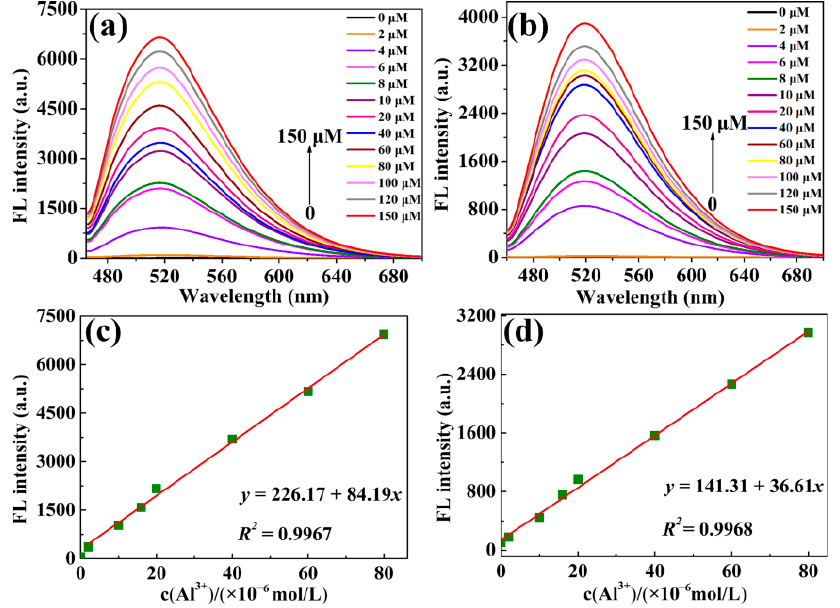
Figure 3. ( a , b ) Fluorescence spectra of L and S in the presence of increasing amounts of Al 3+ (0–150 μ M). ( c , d ) Plot of fluorescence intensities of L and S, respectively. Table 1. Comparison of some fluorescent probes for Al 3+ detection.